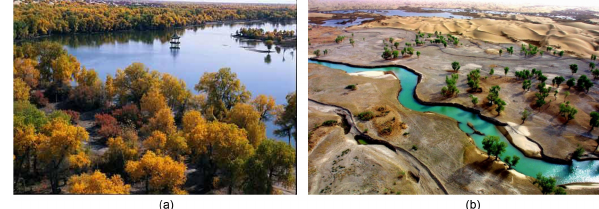
Fig. 1. The landscape of (a) main stream of Tarim River (adapted from http://travel.sina.com.cn/china/2009-03-16/165869875. shtml) and (b) the lower reaches of the Tarim River (adapted from http://my.opera.com/frampa62/albums/showpic.dml?album= 12297572\&picture=160178642).